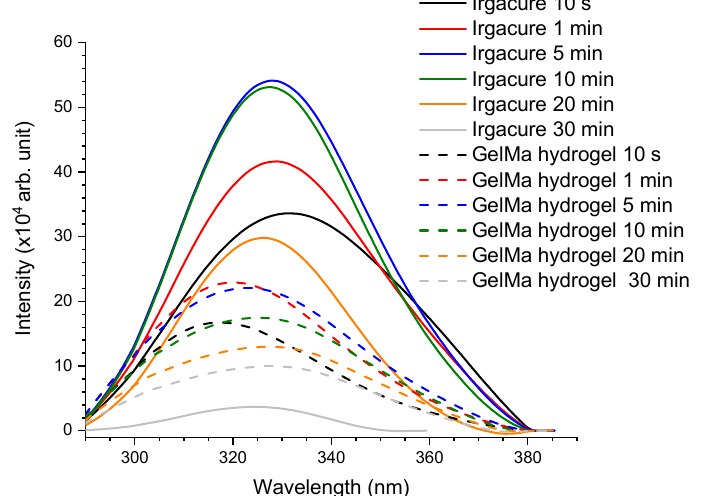
again to fluorescence emission.